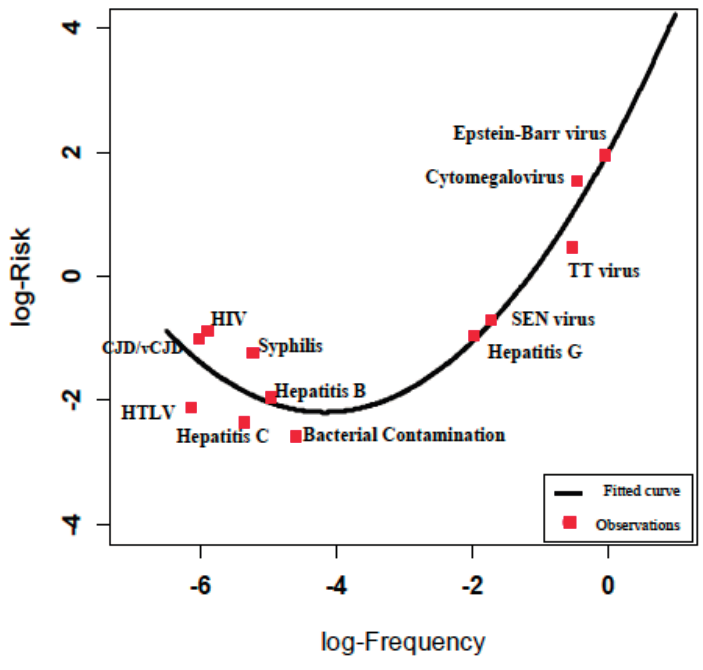
Figure 3. Risk estimation according to log-Risk = log-Frequency + log-Severity.